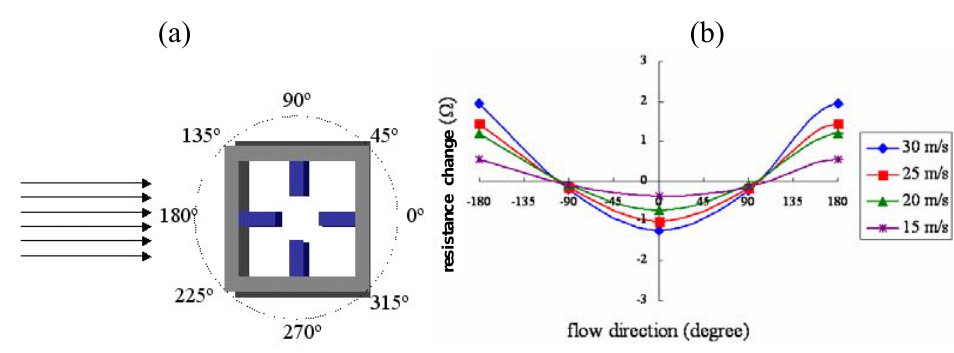
Figure 7. (a) Position of initial air flow direction relative to sensor; (b) correlation between resistance signal variations and air flow direction for air flow velocities in the range of 15~30 ms -1 .